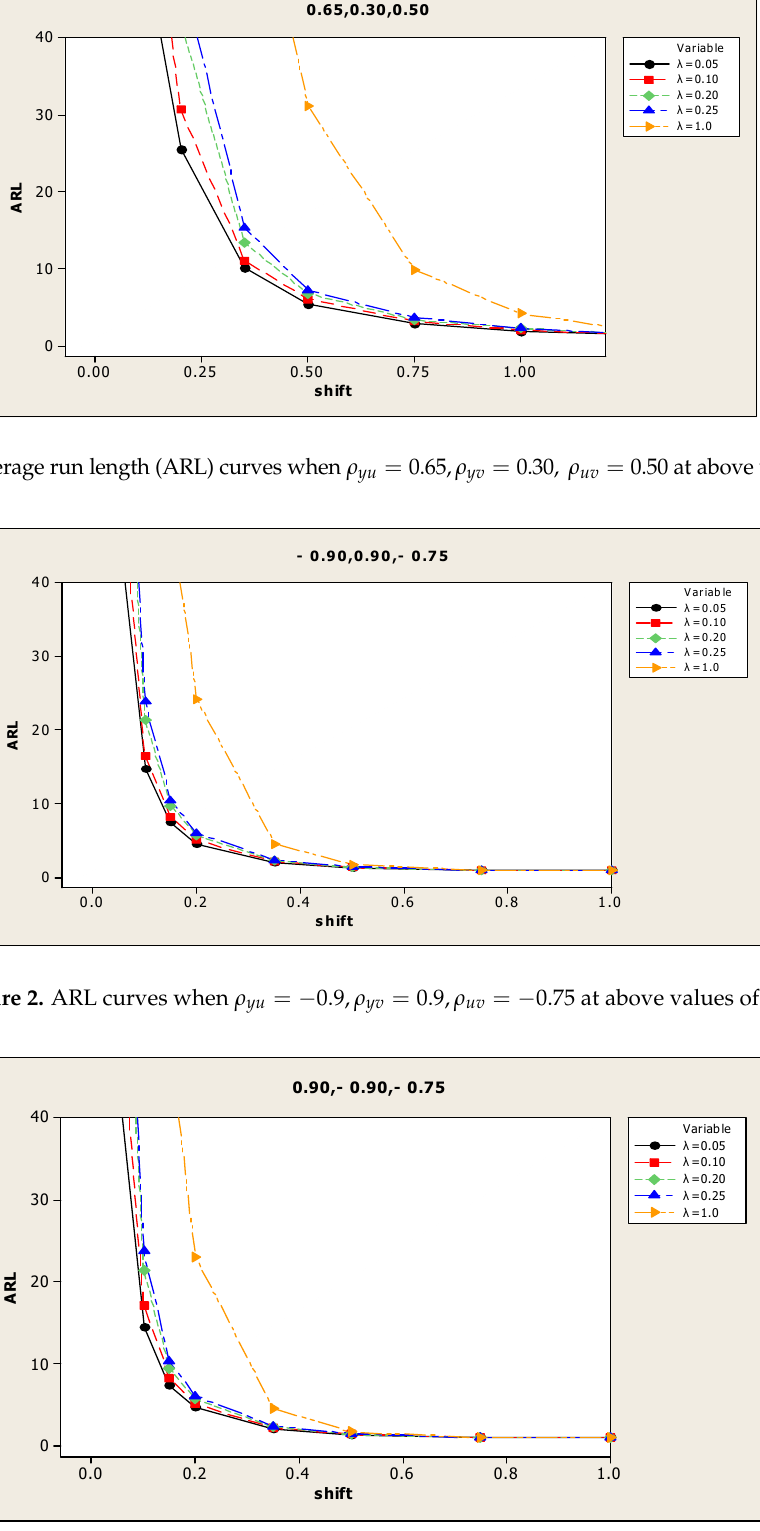
Figure 3. ARL curves when ρ yu = 0.9, ρ yv = − 0.9, ρ uv = − 0.75 at above values of λ